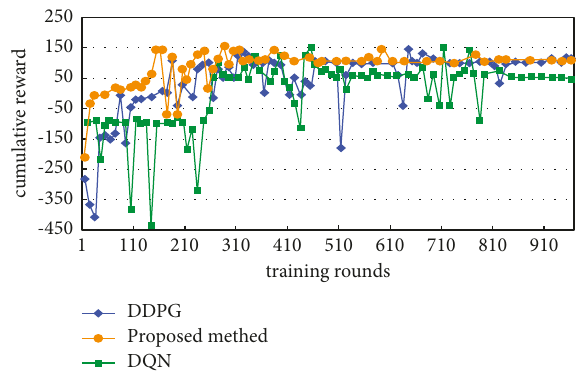
Figure 5: Reward function curve comparison.